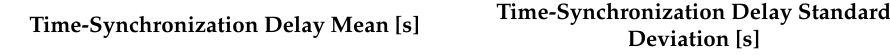
Table 1. Mean and standard deviation of the measured time-synchronization delays for each considered couple of nodes.